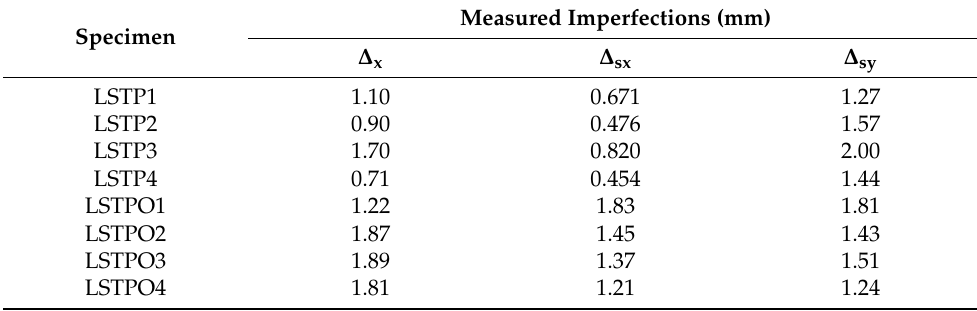
Table 3. Initial geometric